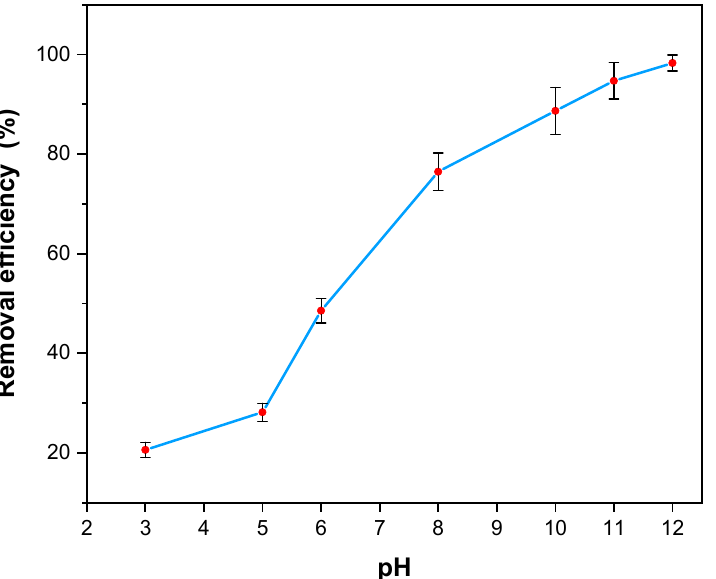
Figure 9. Effect of pH on the photocatalytic removal of MB with B–ZnO/TiO 2 (initial MB concentration: 15 mg/L; photocatalyst amount: 30 mg; pH: 3 − 12; irradiation time: 15 min).